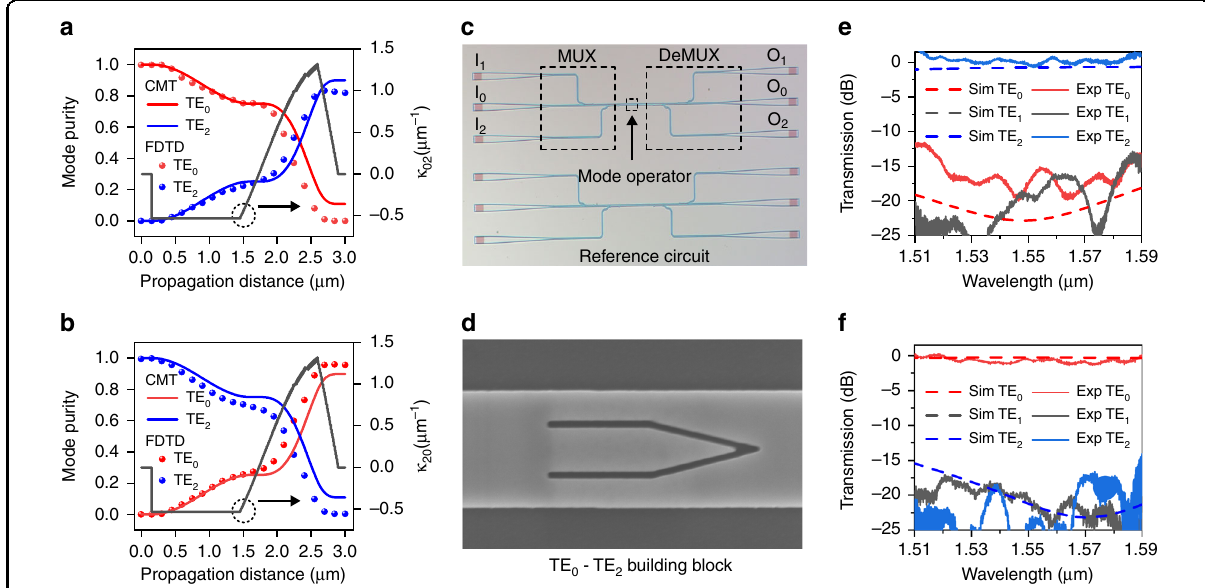
Fig. 2 Simulated and experimental results of the metamaterial BB. a , b Calculated mode purity and coupling coef fi cients as a function of the propagation distance for the TE 0 and TE 2 input mode, respectively. c Microscope picture of the fabricated photonic integrated circuit (PIC) consisting a 3-channel mode multiplexer (MUX), a TE 0 -TE 2 mode operator, and a 3-channel mode demultiplexer (DeMUX). d Scanning electron microscope (SEM) image of a fabricated metamaterial TE 0 -TE 2 BB. e , f Simulated and measured mode conversion ef fi ciency for the TE 0 and TE 2 input mode, respectively. The crosstalk from the TE 1 mode is below − 25 dB in simulation, thus not shown in both fi